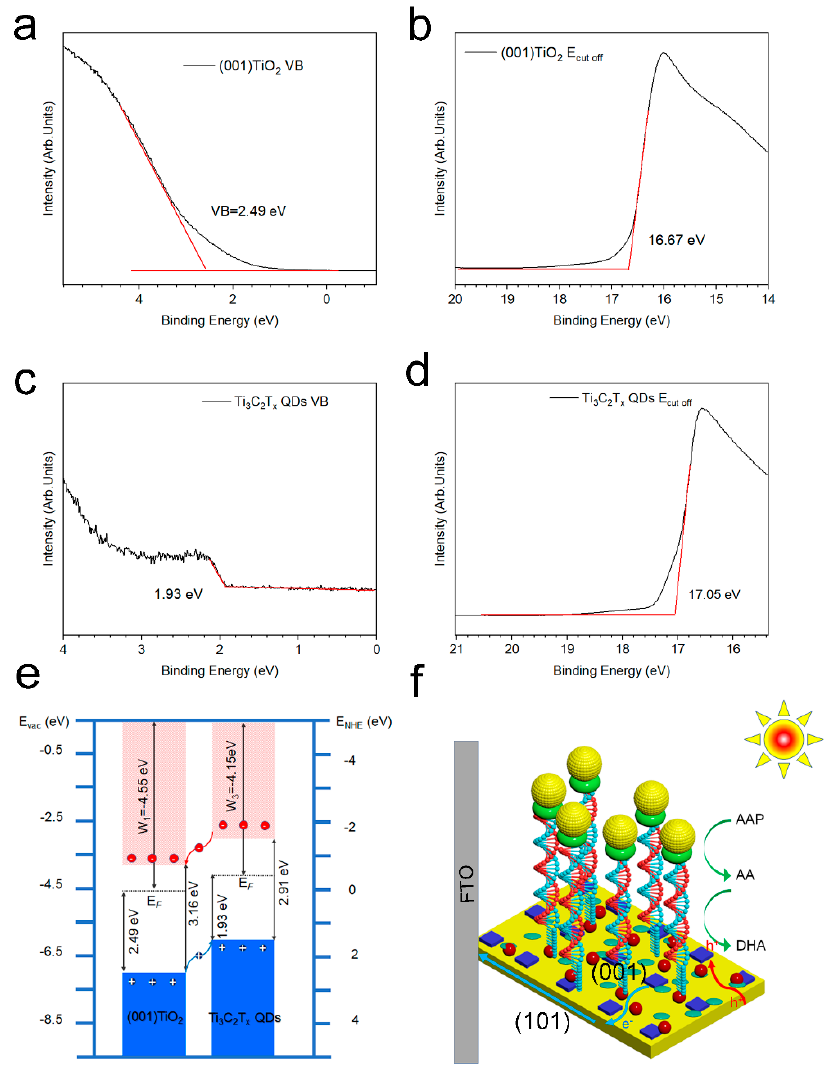
Figure 5. Ultraviolet photoelectron spectra: valence band spectra of ( a ) (001) TiO 2 and ( b )Ti 3 C 2 T x QDs, cutoff energies spectra of ( c ) (001) TiO 2 and ( d )Ti 3 C 2 T x QDs ( e ) band structure of (001) TiO 2 and Ti 3 C 2 T x QDs, and ( f ) schematic of electrode electron transfer.